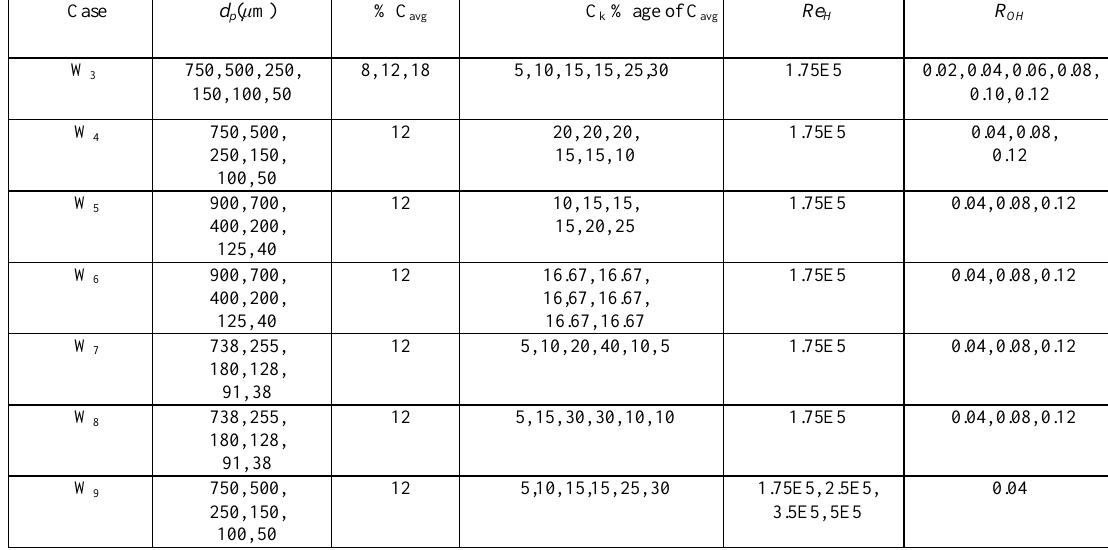
Table 1. List of cases used for parametric studies of solid